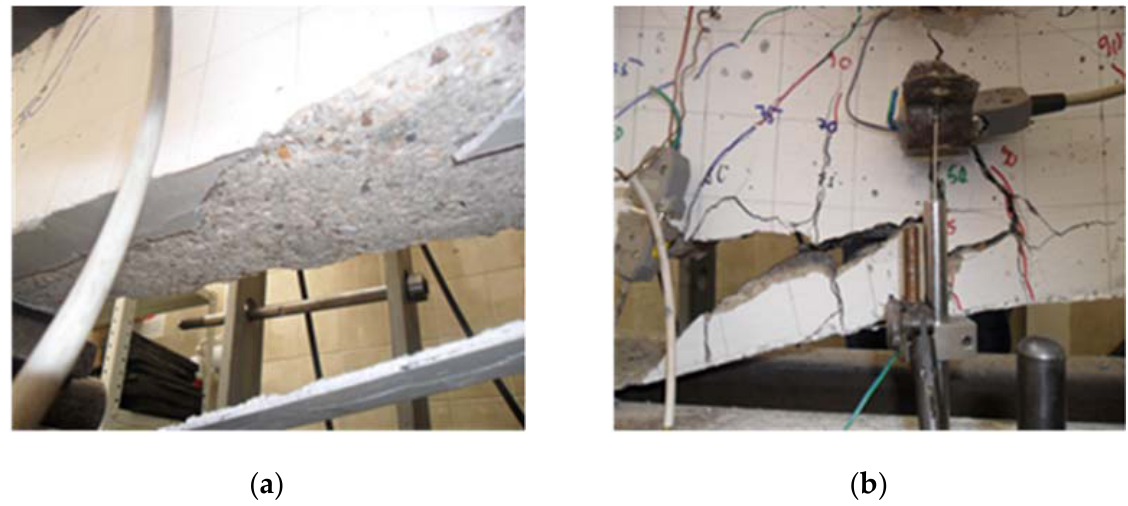
Figure 21. Beam B-EC: ( a ) Debonding at the joint of concrete and epoxy adhesive on the beam bottom side; ( b ) Concrete separation at the level of protective layer of concrete.